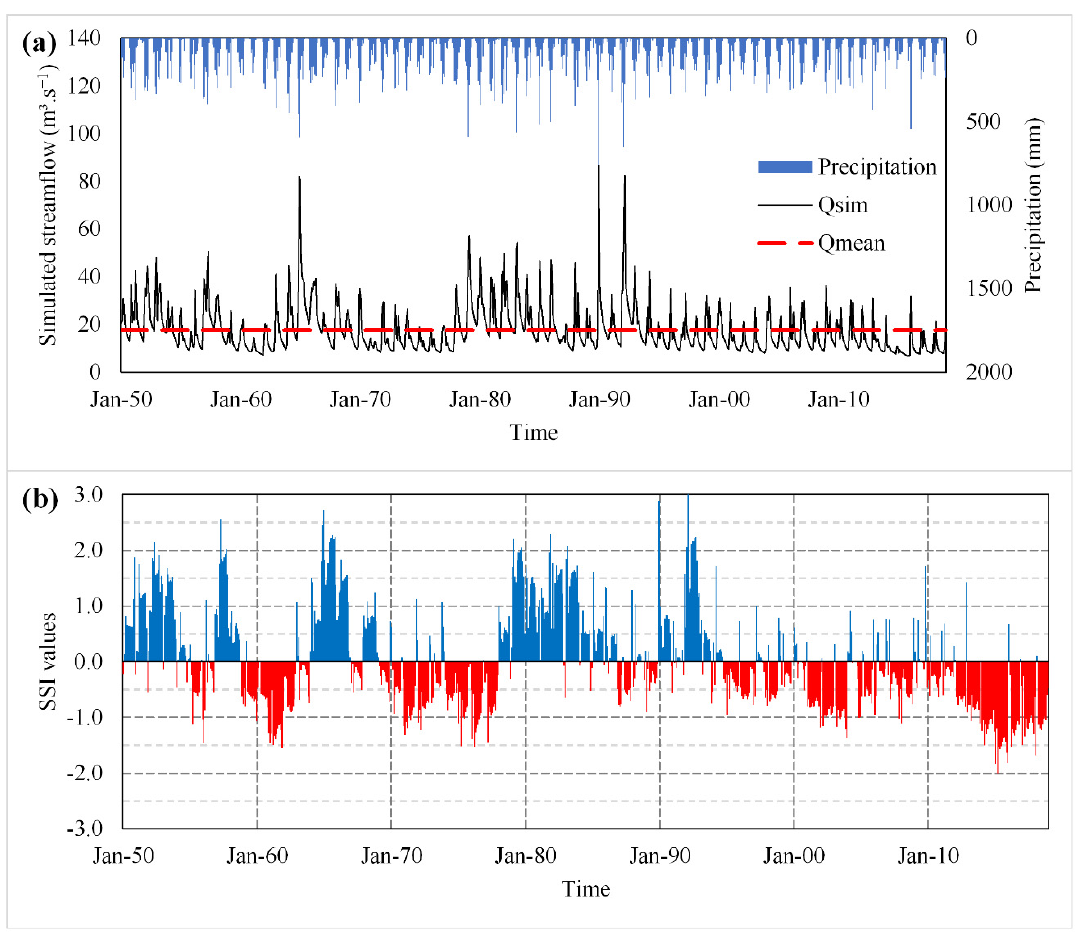
Figure 5. HR (Qsim), mean streamflow (Qmean), and basin-scale precipitation ( a ); historical drought results for PRB from January 1950 to December 2018 ( b ), where blue columns represent SSI above 0 and red columns mean SSI below zero.